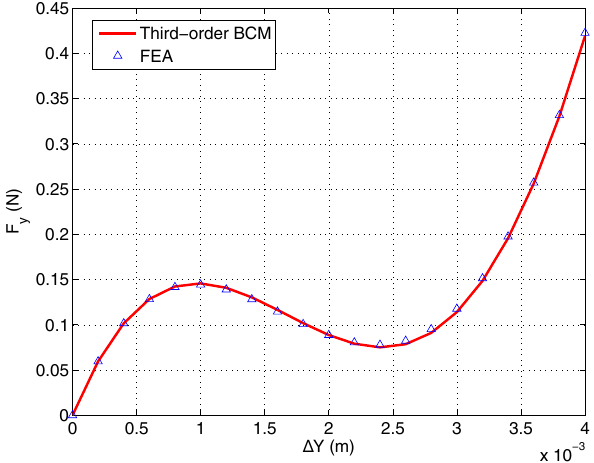
Figure 11. Comparion of the load-displacement relationship of Ex- ample II between FEA and the